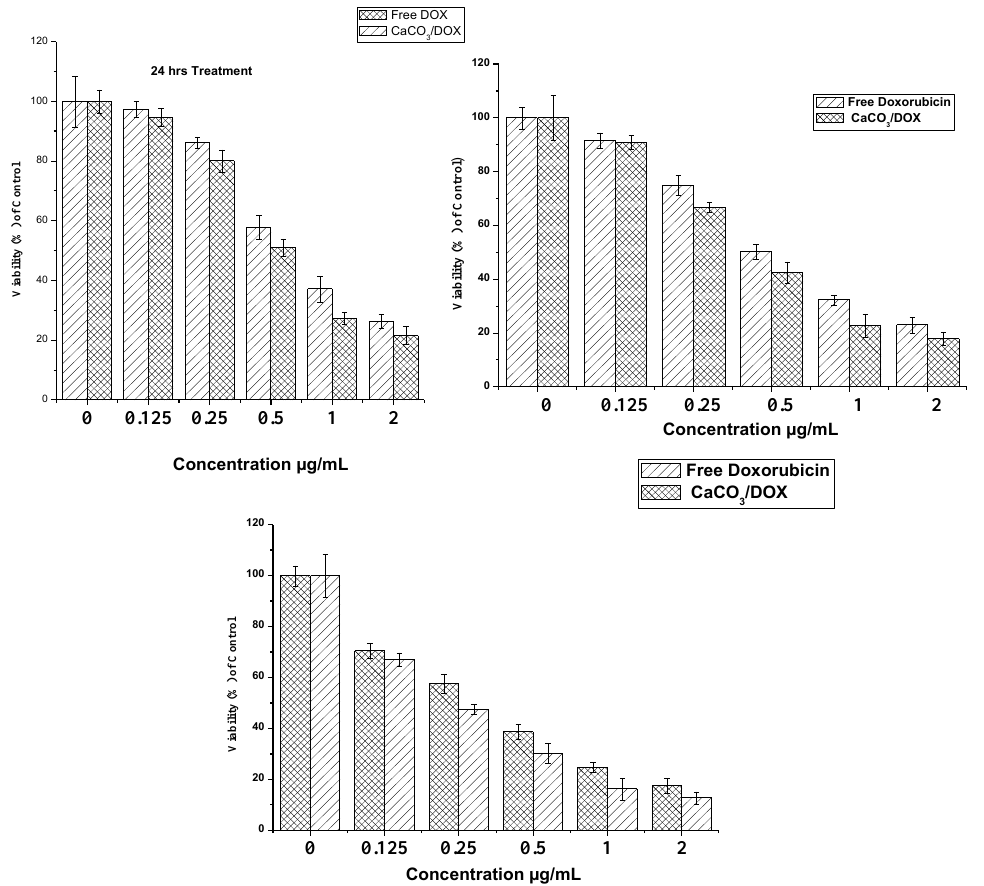
Figure 6. In-vitro cytotoxicity study of MG 63 Osteosarcoma cells after 24, 48 and 72 h of exposure to free DOX and the CaCO /DOX 3